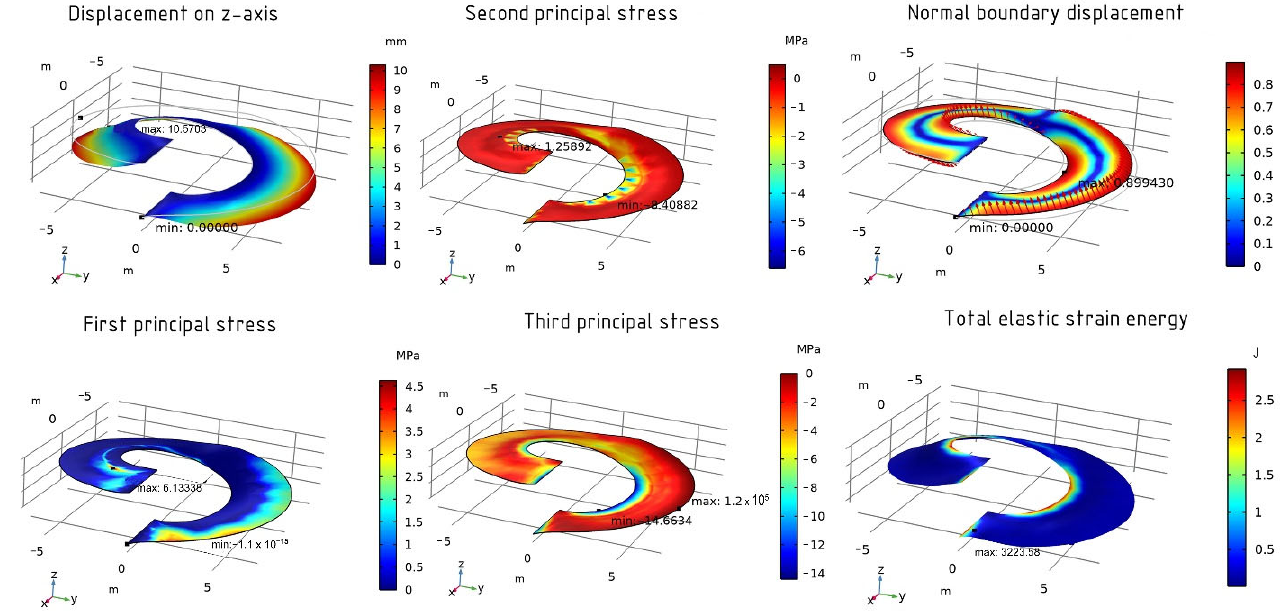
Figure 20. The results of the optimized shell using the MMA method.